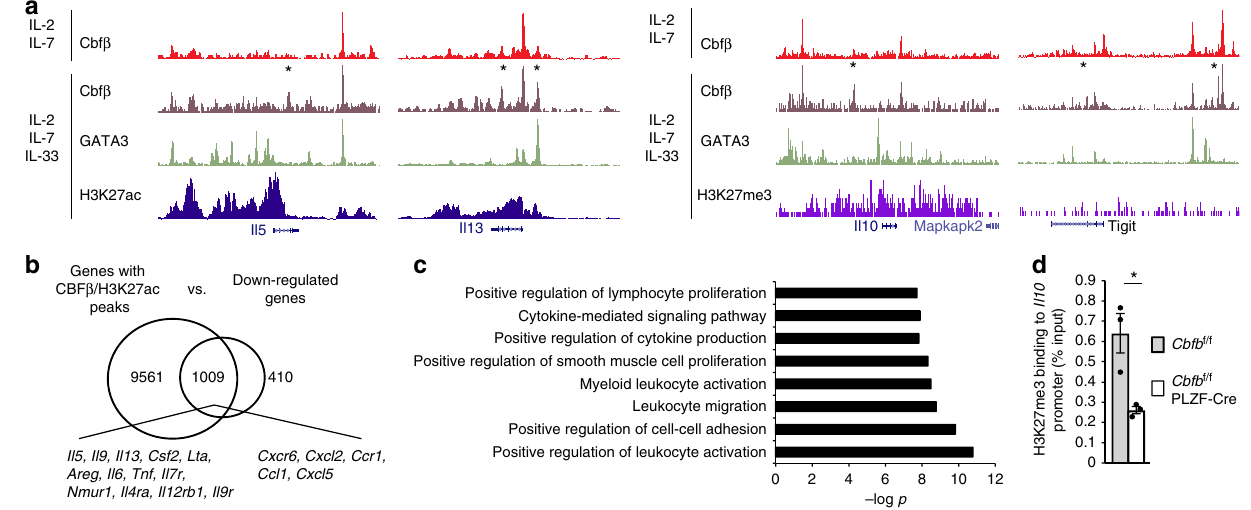
Fig. 6 Enhancer and repressor activities of Runx proteins in ILC2s stimulated with IL-33. a Tracks of Cbf β ChIP sequence traces in ILC2s cultured with IL-2 and IL-7 (top) and Cbf β , GATA-3, H3K27 acetylation (ac), and H3K27 trimethylation (me3) ChIP sequence traces in ILC2s cultures with IL-2, IL-7, and IL-33 (bottom three). Asterisks(*) indicates a differential peak in IL2s cultured with IL-2, IL-7, and IL-33 compared to ILC2s cultured with IL-2 and IL-7. b Venn diagram showing the number of genes with Cbf β binding peaks marked by H3K27ac peaks (left) and the downregulated genes in the Cbf β -de fi cient ILC2s as determined by RNA sequence analysis (right). c Gene ontology enrichment analysis using the top 200 downregulated genes out of the 1009 genes in a (middle). Bar plots indicates the – log p value for GO term enrichment. d H3K27me3 binding to the Il10 promoter locus in the indicated mouse ILC2s cultured with IL-2. IL-7, and IL-33. In d , * p < 0.05 by Student ’ s t -test. Data are representative of two independent experiments (mean± s.d. of three mice in d